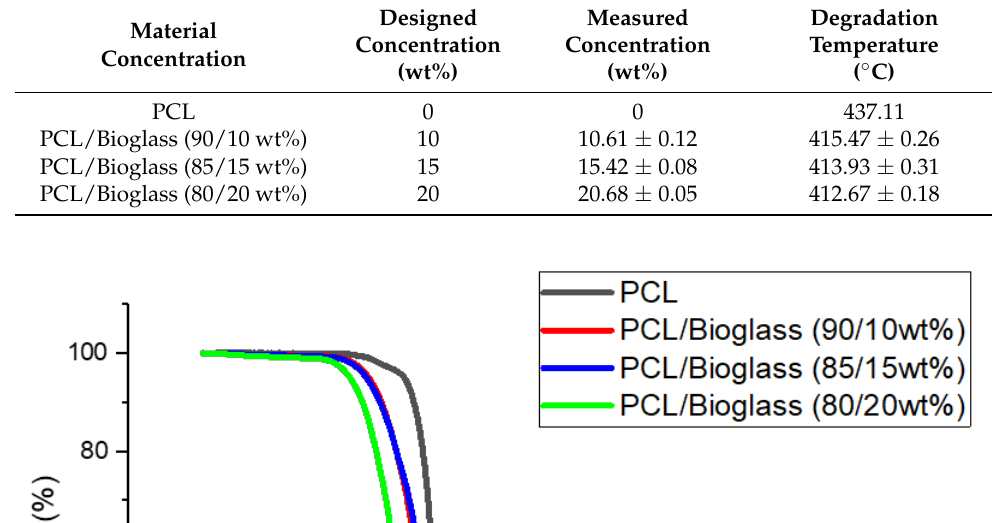
Table 3. The designed and manufactured concentrations of the bioglass bone bricks.